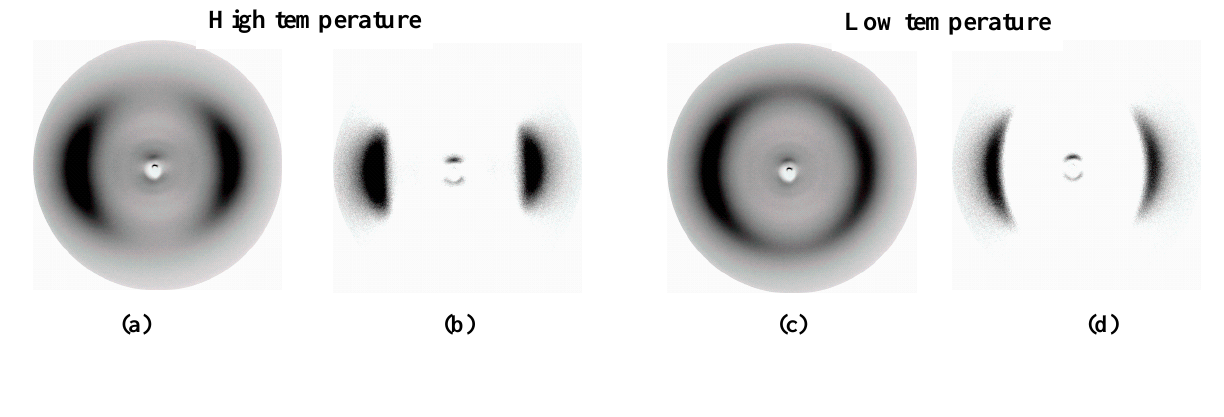
Figure 7. XRD patterns of an aligned sample of the mixture, MGTP201 , in the magnetic field on cooling. ( a , b ) XRD patterns of the nematic phase at 77 °C: ( a ) original pattern; ( b ) the same XRD pattern, but the intensity of the isotropic liquid is subtracted; ( c , d ) XRD patterns of the N at 50 °C: ( c ) original pattern; ( d ) the same XRD pattern, but x the intensity of the isotropic liquid is